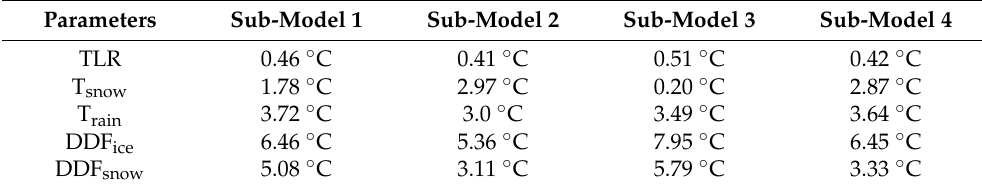
Table 2. The optimal driving data parameters of the sub-models 1–4 for the Yala Glacier.